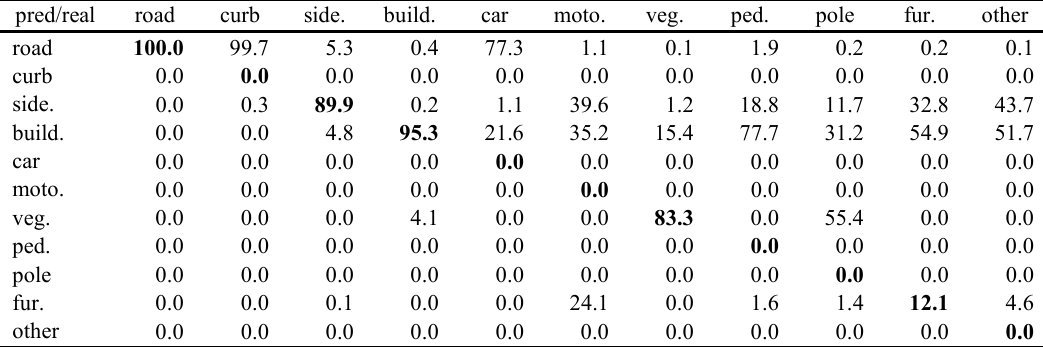
Table 6: Confusion matrix (% recall ) for 11 classes, 200 hidden layers and